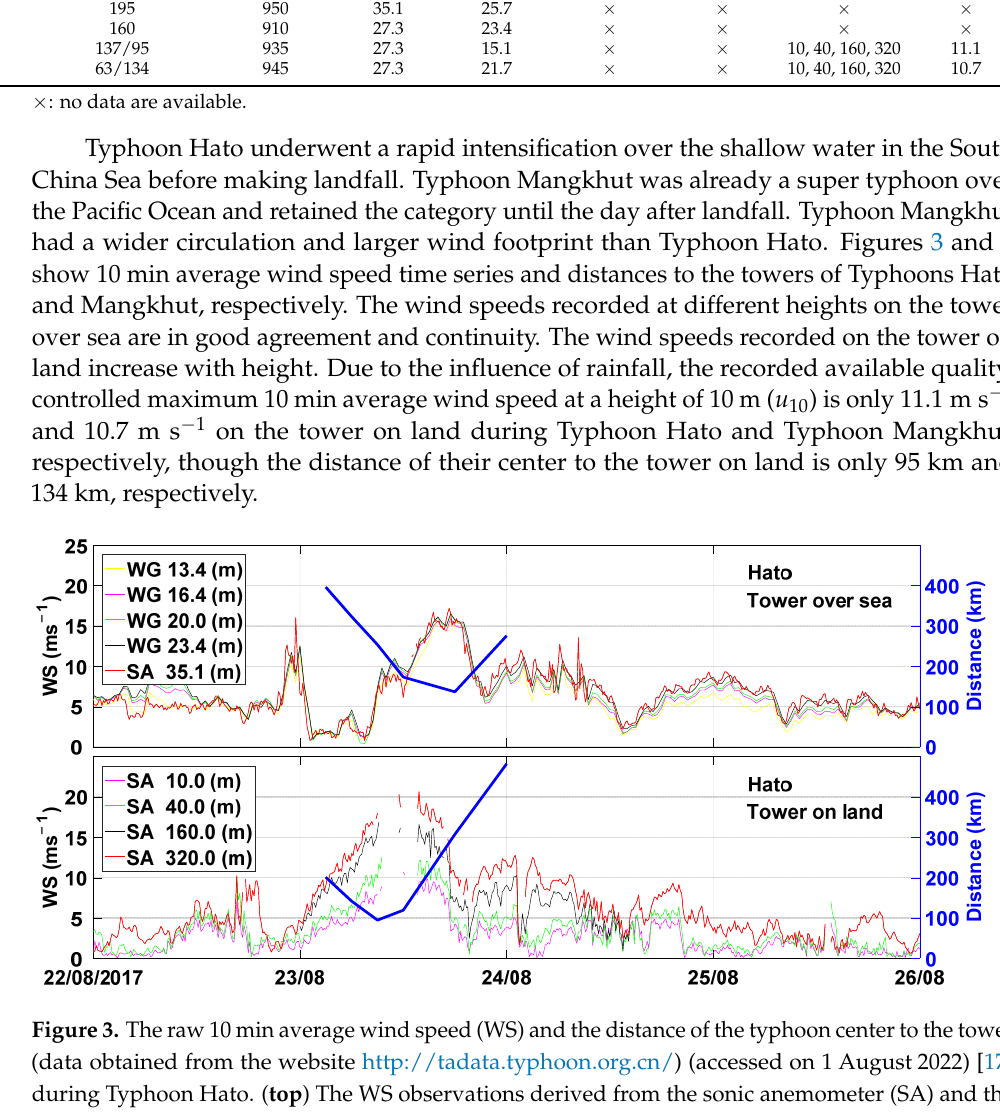
Table1. Information of the data during the seven typhoon events.